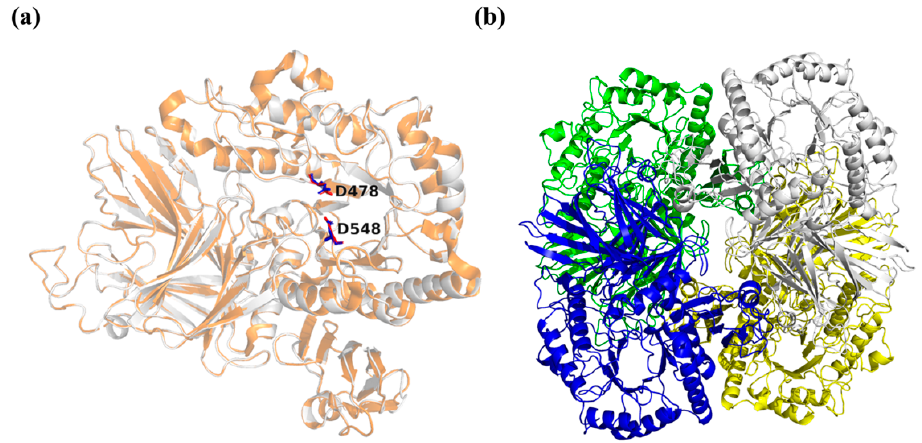
Figure 3. Overall structure of galV. ( a ) Comparison of the quaternary structure of galV (white) and the template (yellow). Sites D478 and D548 are red sticks in galV and blue sticks in the template. ( b ) A schematic representation of the tetrameric α -galactosidase.